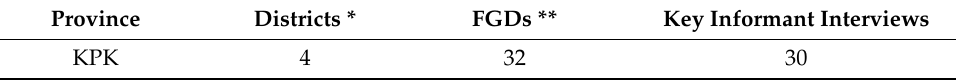
Table 2. Sample size distribution across the four selected districts. Province Districts * Key Informant